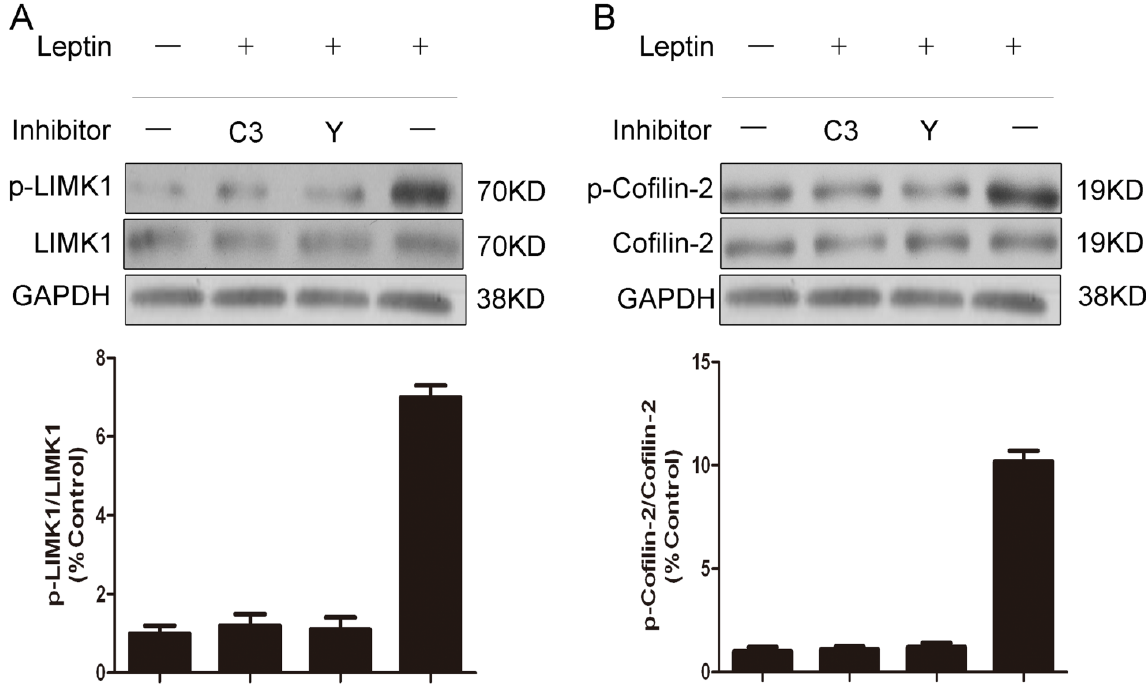
Figure 4. Pharmacological inhibitors of Rho and ROCK prevented phosphorylation of LIMK1 and confilin-2 induced by leptin. NP cells were serum-starved for 24 h, and then pre-treated with C3 (C3 exoenzyme) or Y (Y-276320) for 30 min. The cells were then treated with vehicle ( − ) or 10 ng/mL leptin (+) in serum-free media for another 30 min. the protein amounts of phosphorylated forms of LIMK1 (p-LIMK1) ( A ) and confilin-2 (p-confilin-2) ( B ) were detected with Western blotting analysis. GAPDH was also detected as a loading control. The signal in each lane was quantified using ImageJ software (v. 2.1.4.7; National Institutes of Health, Boston, MA, USA) and the ratios of p-LIMK1/LIMK1 and p-confilin-2/confilin-2 to GAPDH were